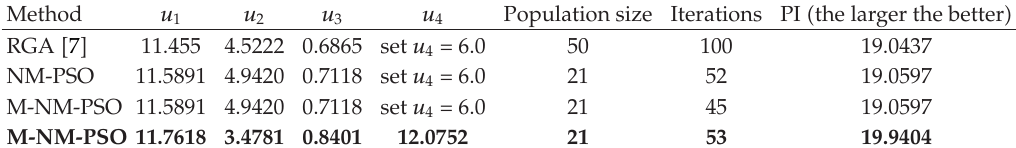
Table 5: Results of Case 3 (cid:3) An isothermal CSTR problem (cid:4) .